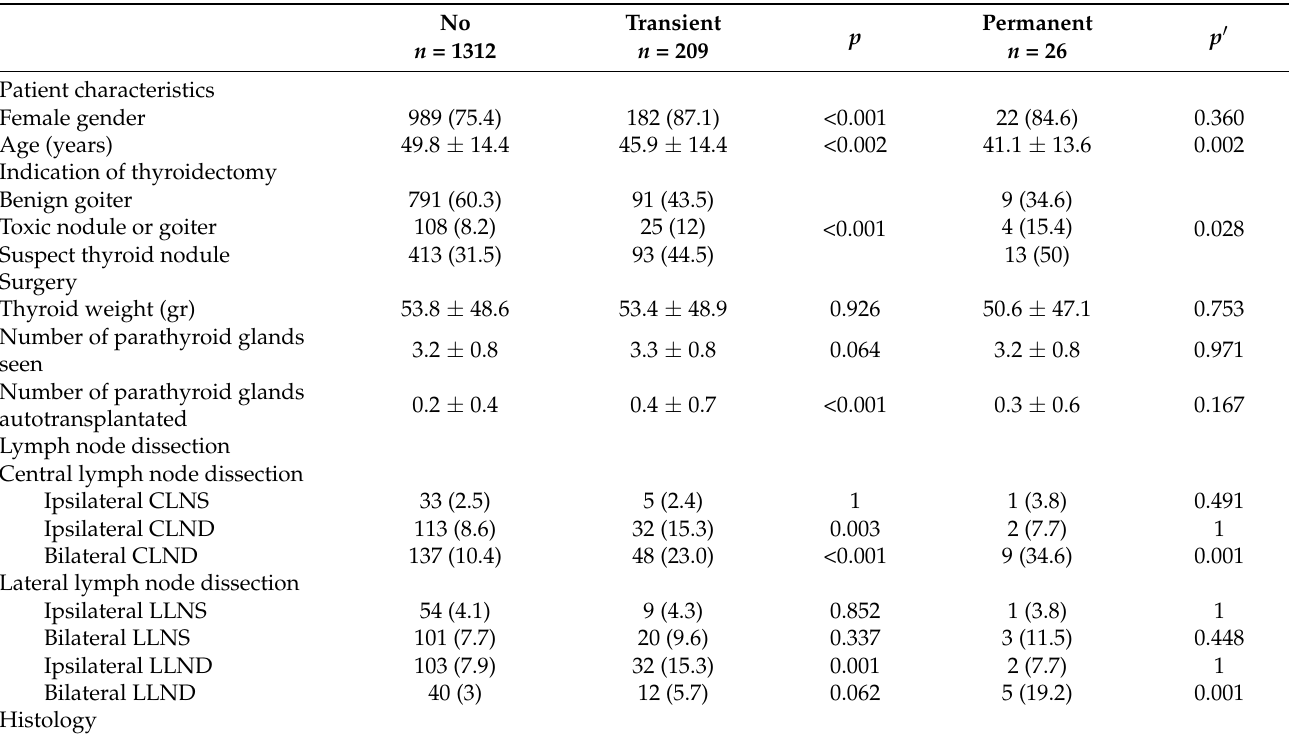
Table 3. Univariate analysis of predictive factors associated with transient and permanent hy-